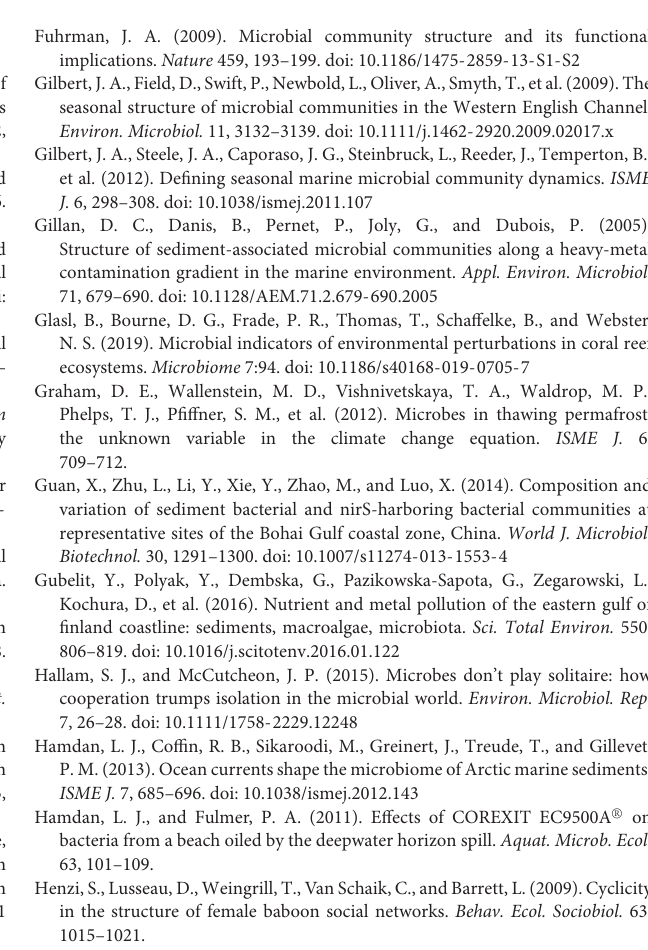
FIGURE S1 | Particle size distribution curve of sediment samples. FIGURE S2 | Proportion of bacteria at the phylum level. u_ indicates unclassified. FIGURE S3 | CCA analysis of microbial and environmental factors. FIGURE S4 | Network of microorganisms based on 39 samples. TABLE S1 | Environmental variables of all sediment samples. TABLE S2 | Biodiversity indices of bacterial communities. TABLE S3 | Genera in different modules from network